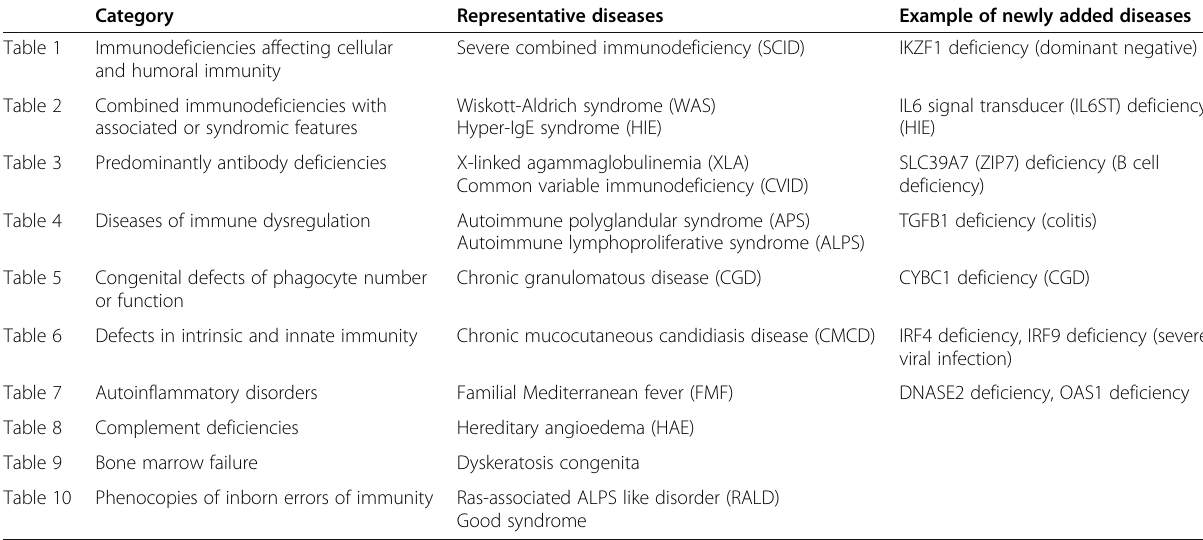
Autoinflammatory disorders Familial Mediterranean fever (FMF) Complement deficiencies Hereditary angioedema (HAE) Bone marrow failure Table 10 Phenocopies of inborn errors of immunity Ras-associated ALPS like disorder (RALD) Good